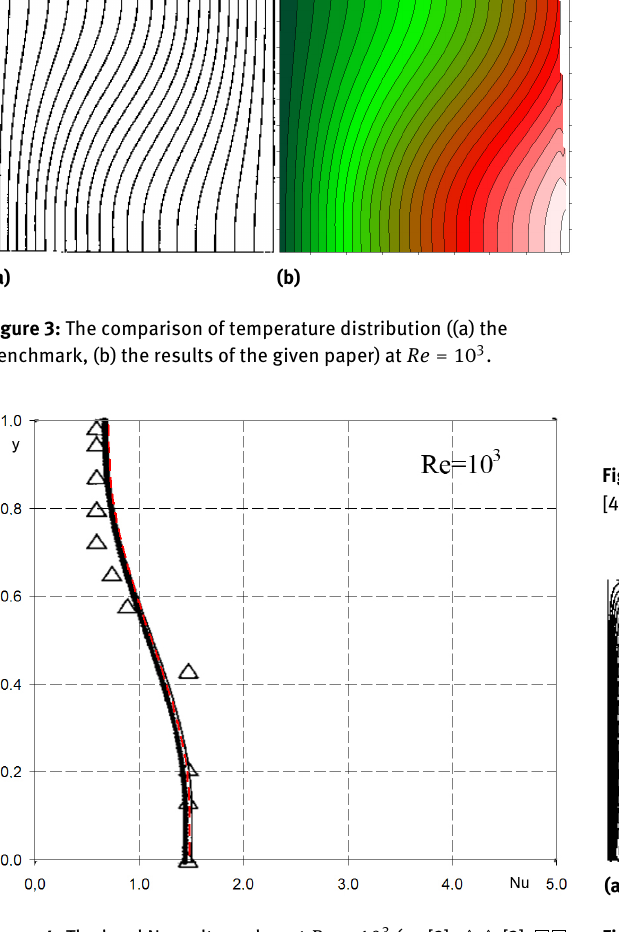
Figure 7: The comparison of temperature distribution ((a) the benchmark, (b) the results of the given paper) at Re = 10 7